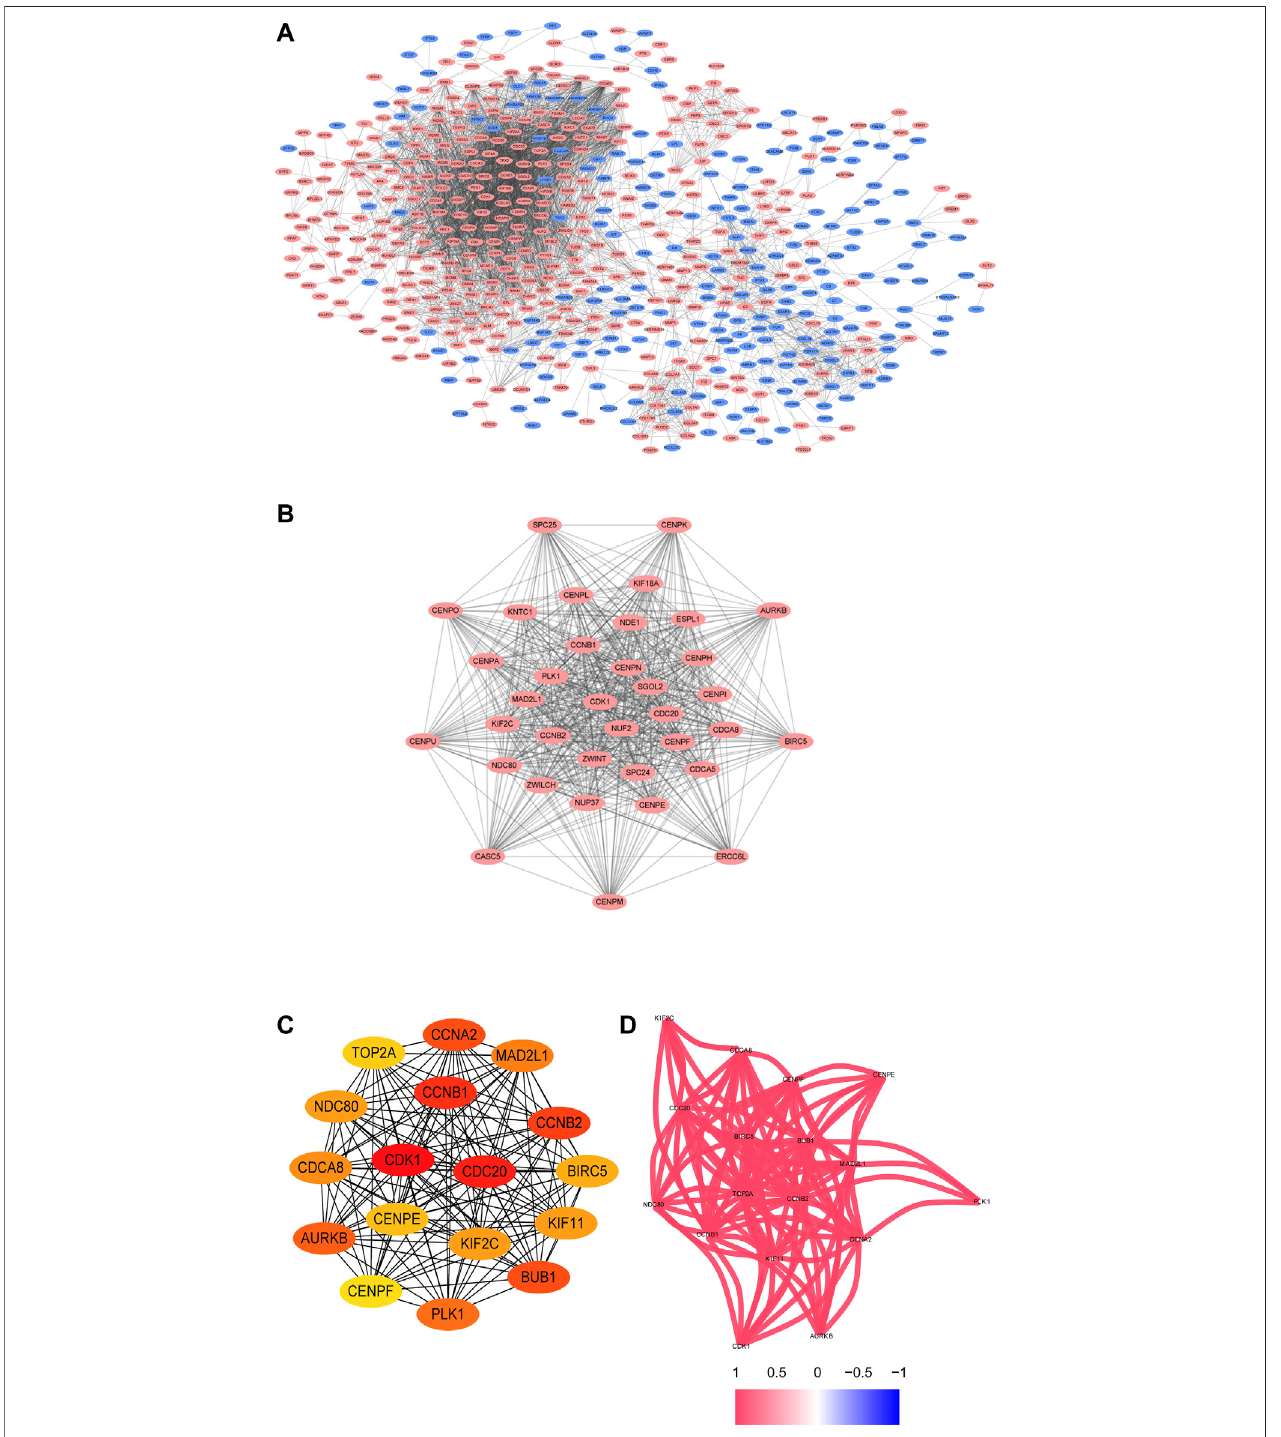
FIGURE 3 | The PPI network and the two most signi fi cant modules of DEGs. The PPI network of DEGs is constructed using Cytoscape (A) . The most signi fi cant module is acquired from the PPI network with 37 nodes and 665 edges (B) . 17 hub genes are shown (C) . The correlation network of the hub gene is illustrated (D) . Upregulated genes are marked in red, and downregulated genes are marked in blue.